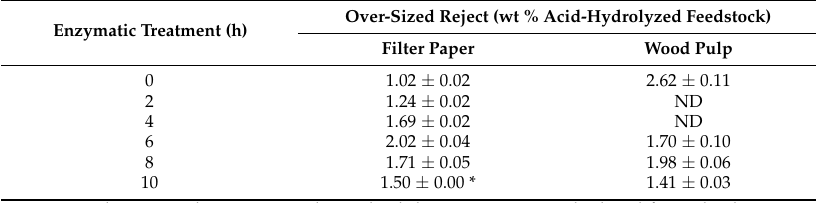
Table 3. Over-sized reject from acid hydrolysis of cellulase cocktail-treated filter paper and wood pulp. Enzymatic Treatment (h)